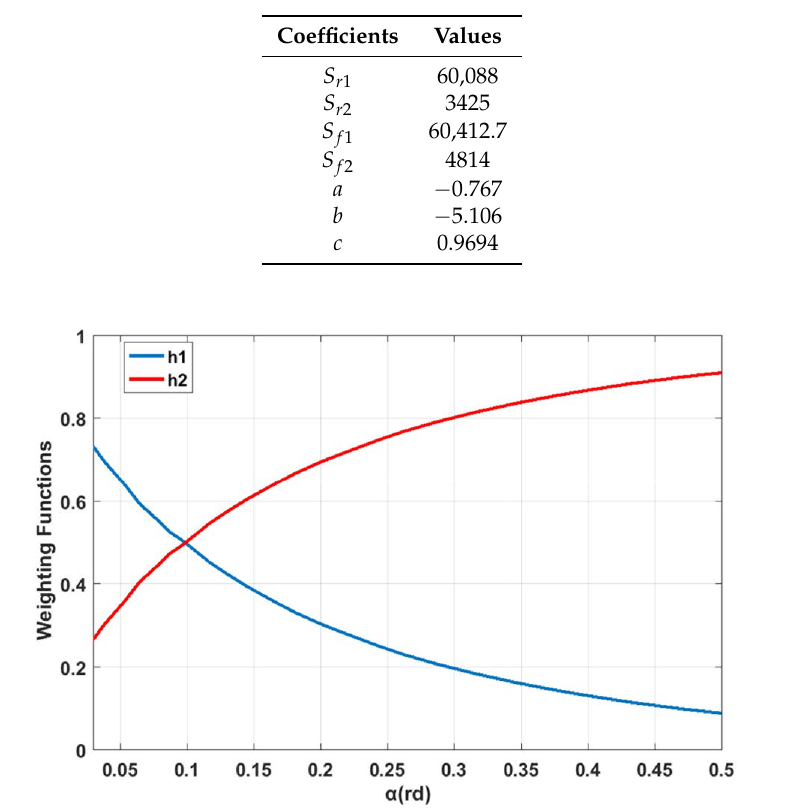
Table 1. The values of lateral forces multiple model parameters.